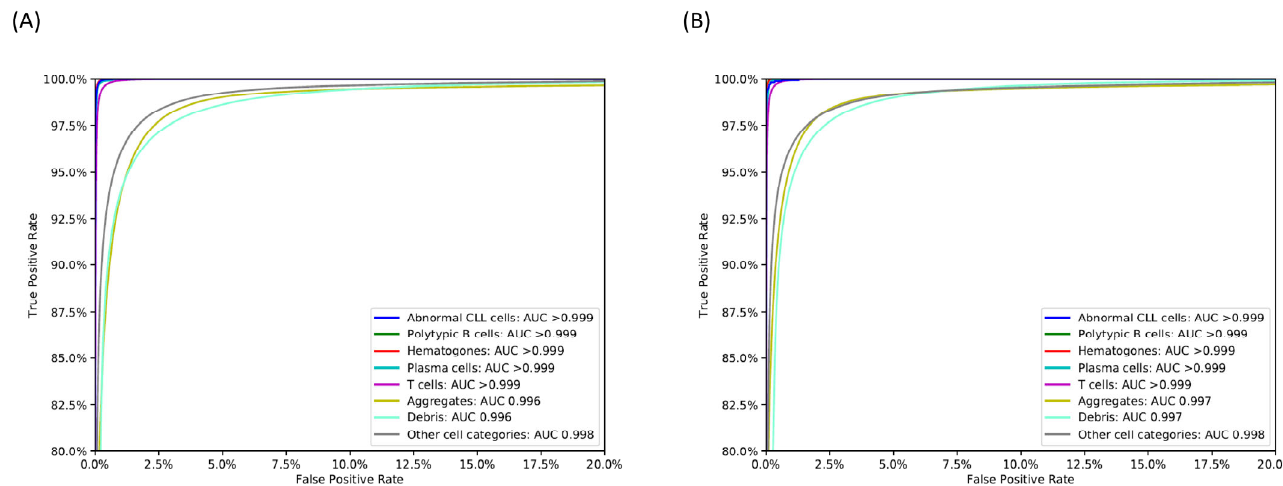
Figure 1. Receiver operating characteristic (ROC) curves for relevant cell classes in the test cohort for the ( A ) F-DNN network and ( B ) L-DNN network, with corresponding area under ROC (AUC). CLL: chronic lymphocytic leukemia. Other cell categories include granulocytes, monocytes, natural killer (NK) cells, blasts, erythroblasts, basophils, and dendritic cells; these populations were identified as individual classes by the DNN but combined into a single category for visualization purposes.